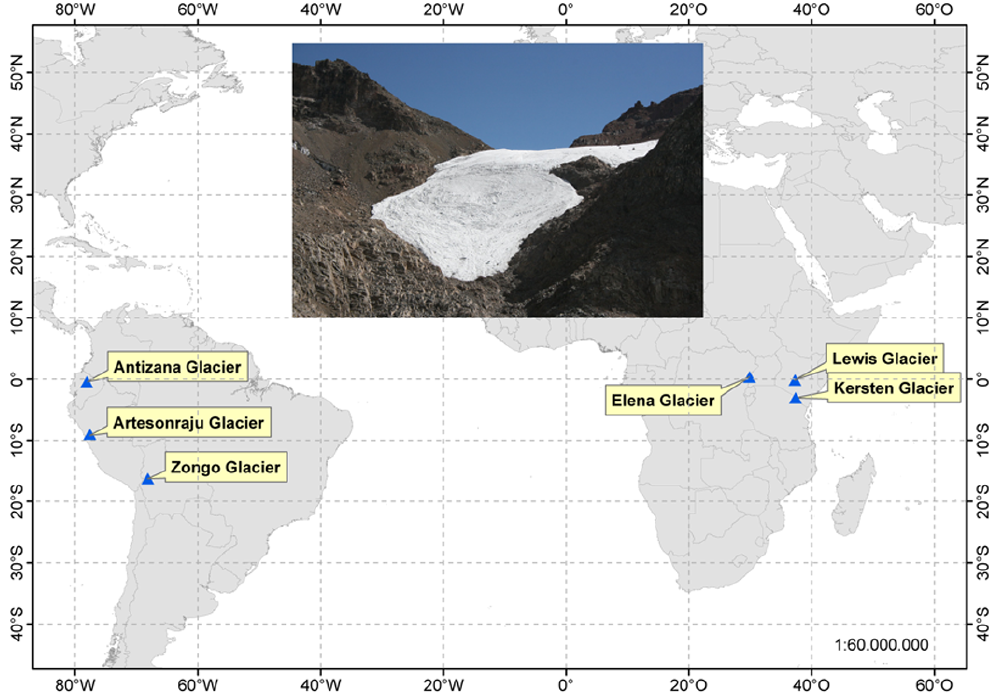
Fig. 1. Location map of the tropical glacier sites referred to in this study, with an inset showing Lewis Glacier in February 2012 (photo credit: Stephan